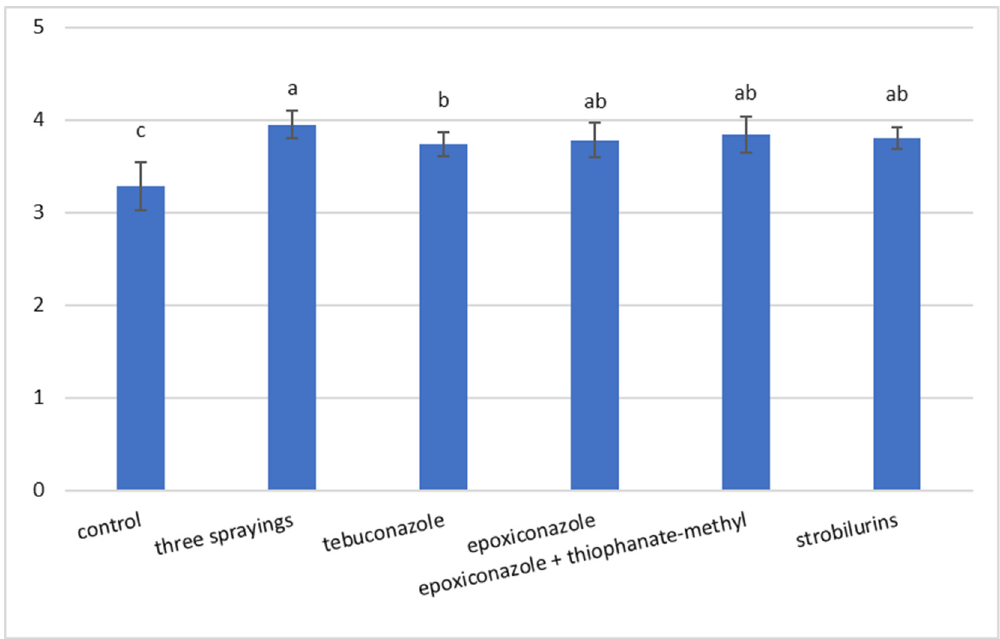
Figure 2. Leaf Area Index—LAI-2 (±SD) for sugar beet depending on fungicidal protection method, averaged for the study years; a, b, c—the same letters indicate no significant differentiation.